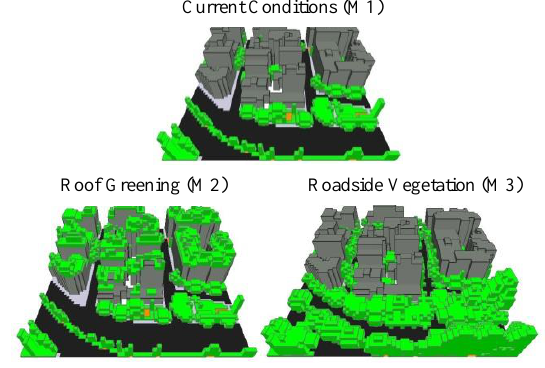
Figure 4. Simulated Scenarios of